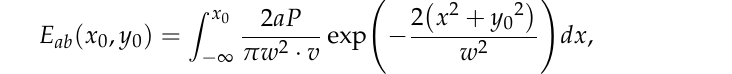
Figure 14. Control surface based on energy balance during single-pulse laser drilling process. For the infinitesimal control surface at the point ( x 0 , y 0 ), E ab , E vap , and E cond denote the laser absorption energy, vaporization energy, and conduction energy, respectively. In Equations (2)–(4), considering the spatial distribution of the beam energy, E ab on a point ( x 0 , y 0 ) from the beam center, at a distance x 0 along the x -axis and y 0 along the y -axis from the beam axis, is given by Equation (11).